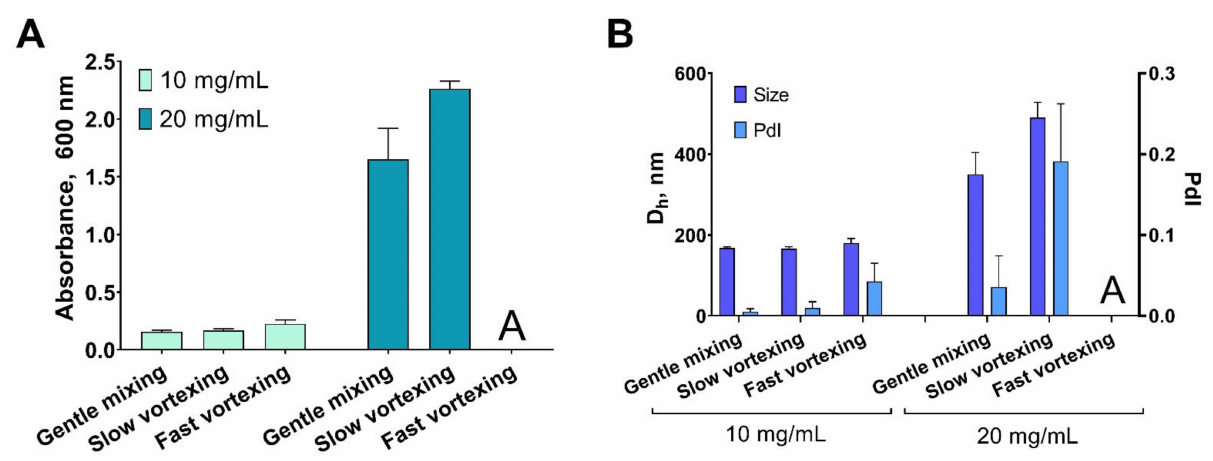
Figure 1. Influence of stirring intensity of the turbidity ( A ) and size ( B ) of gelatin nanoparticles. Dh—hydrodynamic diameter; PdI—polydispersity index. Mean values of three individual batches are shown, mean ± SD. Symbol “A” stands for aggregation.